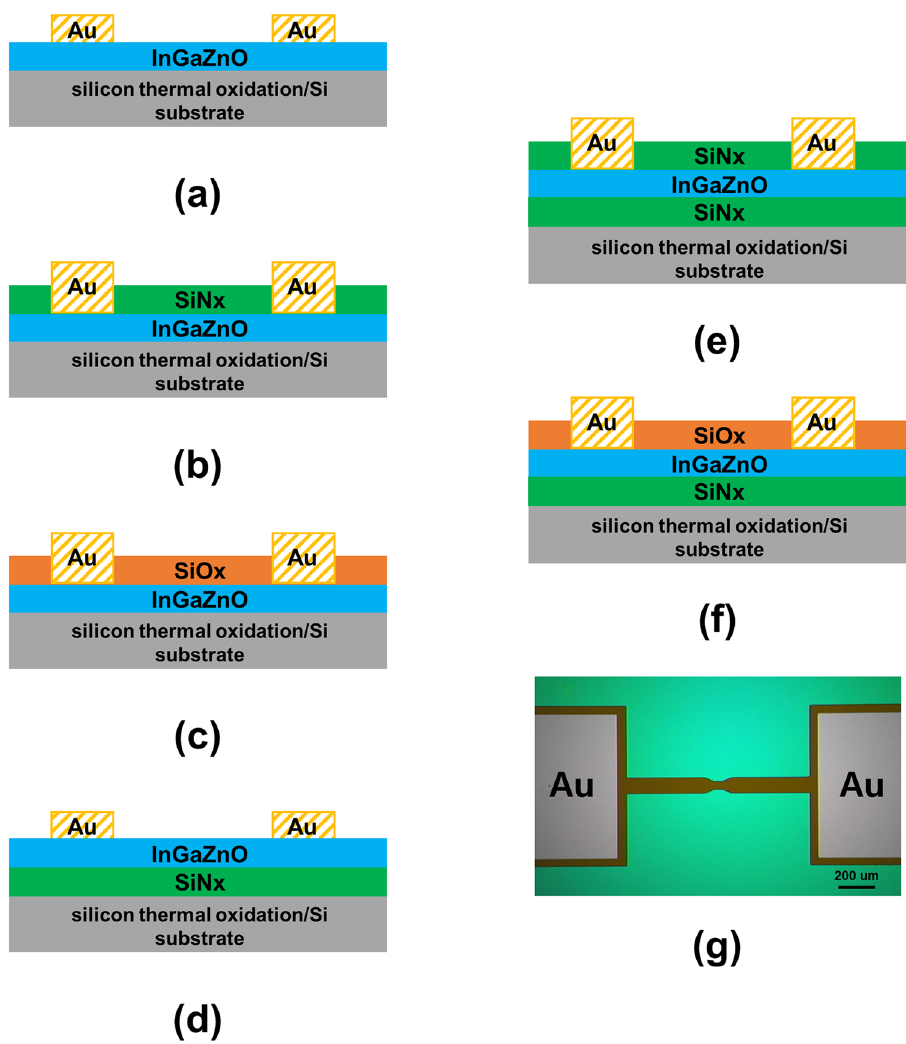
Figure 1. ( a )–( f ) Cross-sectional schematics of a -IGZO structures covered with SiO x and/or SiN x , ( g ) microscopy image of a -IGZO resistor